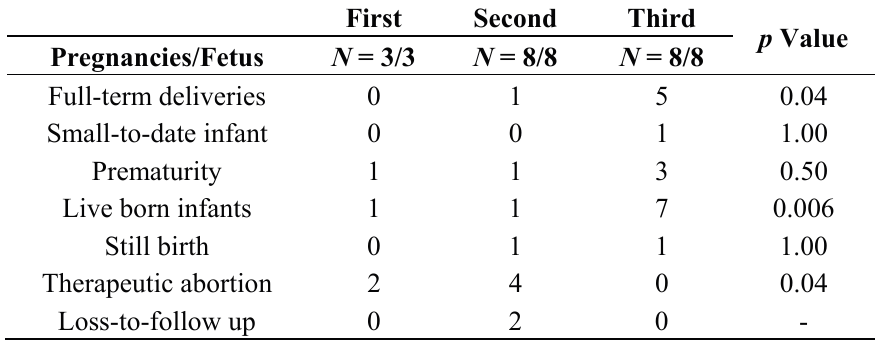
Table 5. Fetal outcome of patients with new onset SLE during